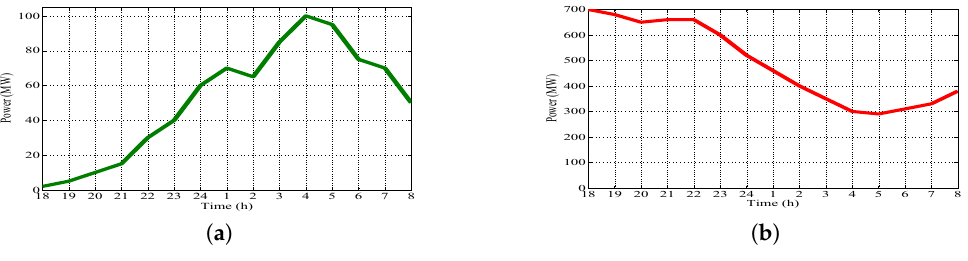
Figure 4. Wind Power and System Load. ( a ) Predicted wind power; ( b ) system load with no